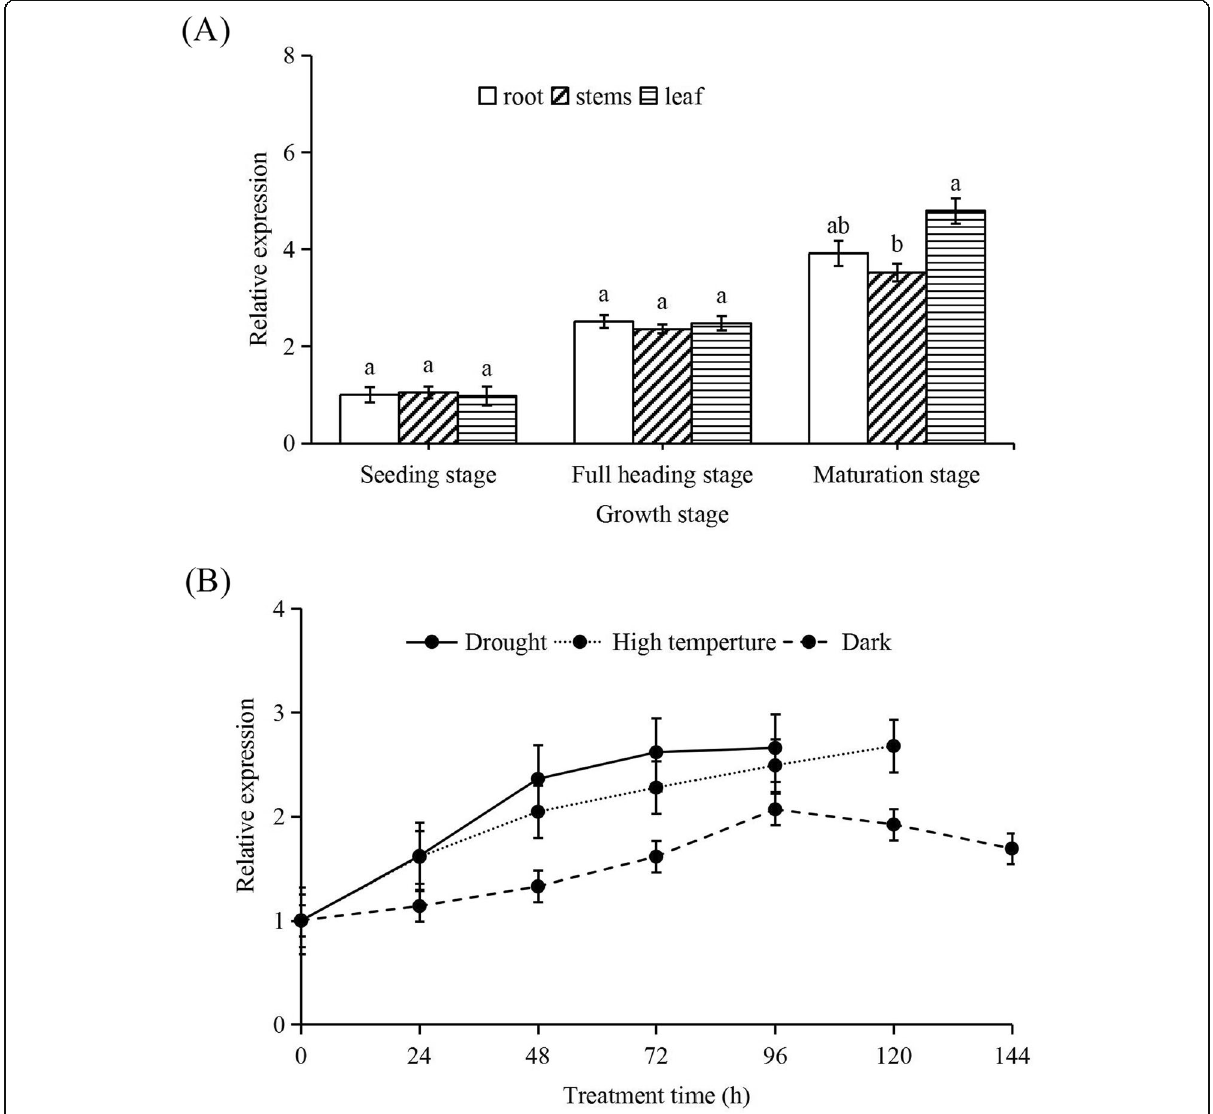
Fig. 1 Expression pattern analysis for OsXDH. a Expression level of OsXDH in various tissues of rice at different growth stages. The sampling at seedling stage was 14 days after sowing, and the sampling at full spike and maturity stages were 60 days and 90 days after sowing, respectively. The sampled leaves were the penultimate leaves, the sampled stems were located near the penultimate leaf, and the young roots were collected for expression pattern analysis of OsXDH . b Expression levels of OsXDH in rice leaves under different stresses. Equal numbers of seedlings at the 4 – 5 leaf stage were selected for each stress treatment, Samples were collected every 24 h with acquisition of main stem and fully expanded leaves in different adversity handling processes. Values are means±SEM, n = 3. Significant differences ( P < 0.05) are denoted by